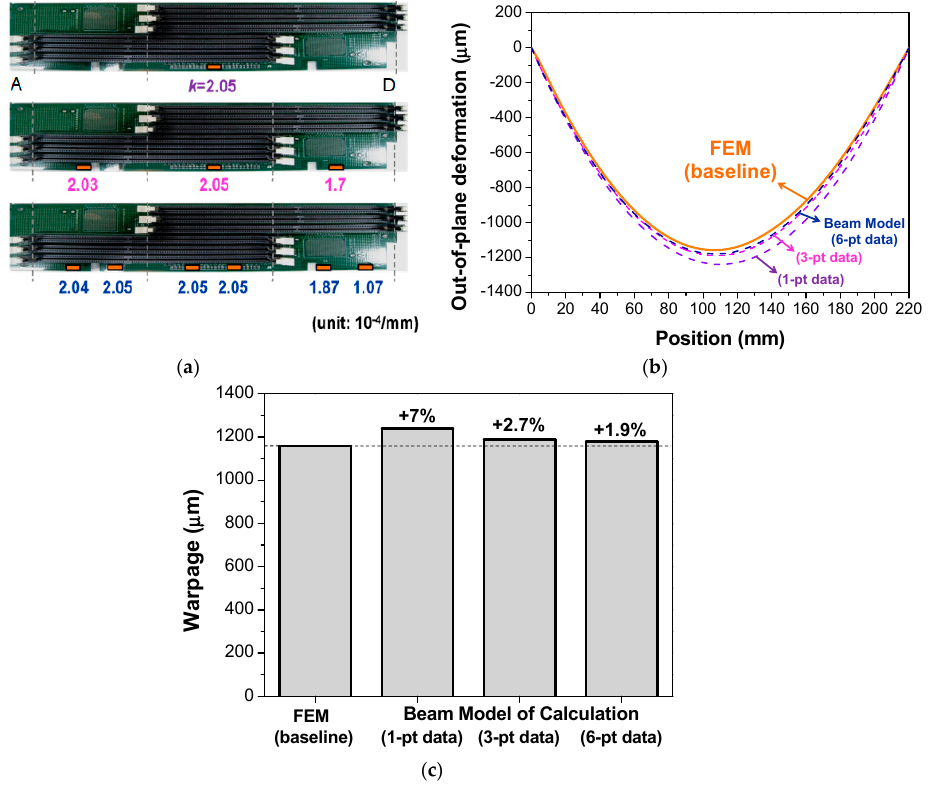
Figure 13. ( a ) Given curvature data (at one, three, and six points) obtained from the FEM simulation (representing data from the strain gauge measurement); ( b ) out-of-plane deformation of the PCB assembly along line a-d obtained from the simple beam model, compared with the FEM simulation (baseline); ( c ) warpages from the simple beam model of calculation with various numbers of curvature (or strain) data.